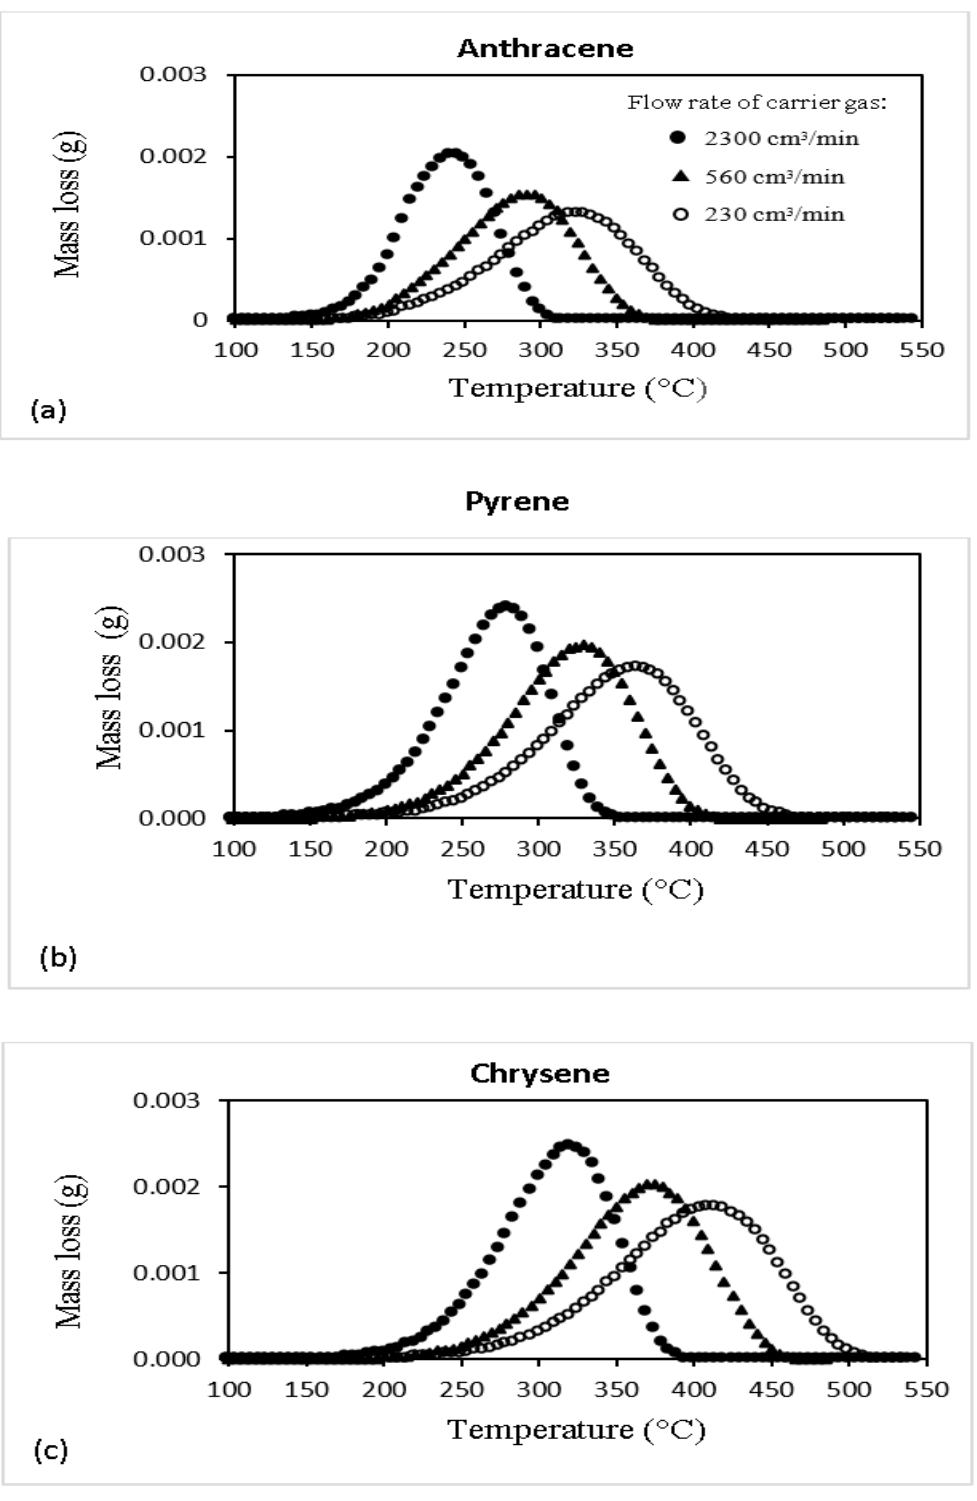
Figure 9. Estimated mass loss of ( a ) anthracene, ( b ) pyrene and ( c ) chrysene versus temperature for different carrier gas flow rates. Solid circle: 2300 cm 3 /min, solid triangle: 560 cm 3 /min, empty circle: 230 cm 3 /min (heating rate: 50 °C/h and 𝜙 (cid:3036) 𝑠: 1(cid:4667) .